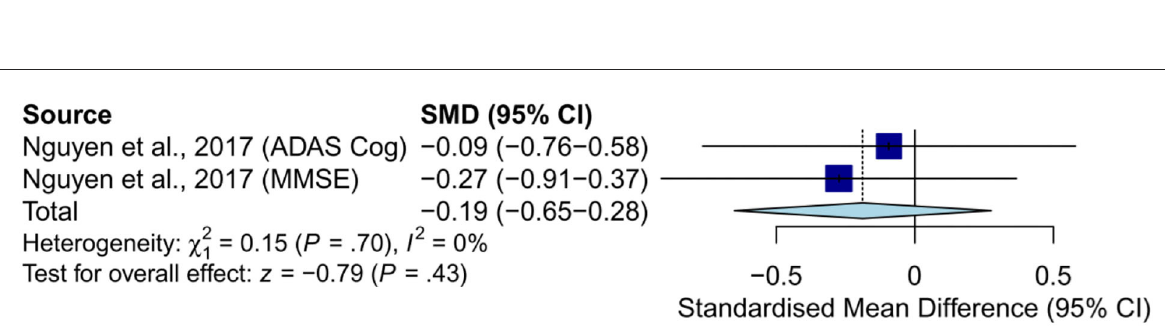
= − 0.19, 95% CI: − 0.65–0.28, p = 0.43; [heterogeneity: χ 2 = 0.15, df = 1, p = 0.70, I 2 = 0%]) (Figure 3) (Nguyen et